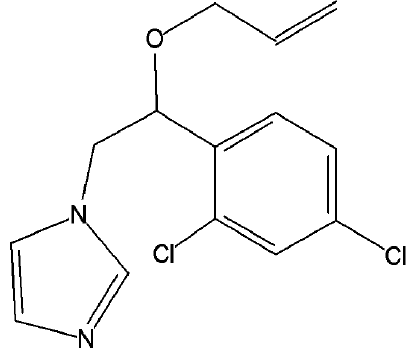
Fig. 1 Chemical structure of imazalil (1-[2-allyloxy-2-(2,4-dichloro-phenyl)-ethyl]-1H-imidazole, CAS 73790-28-0, M.wt.